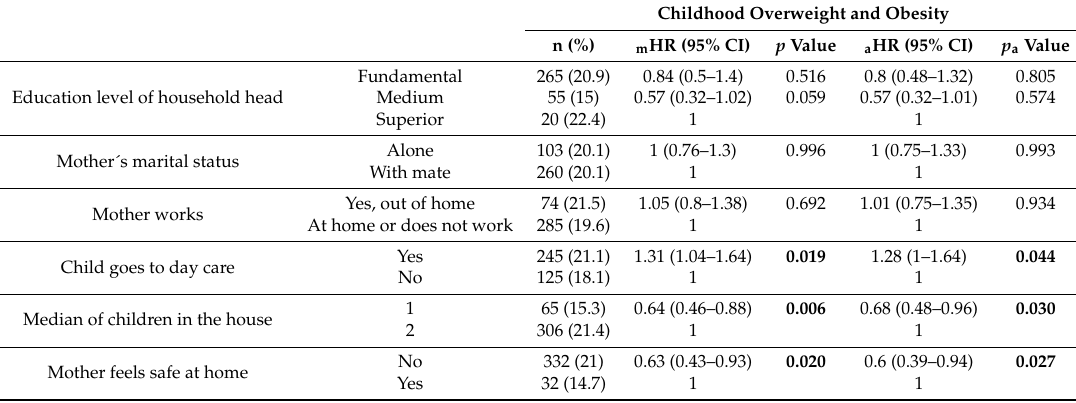
Table 3. Home environment factors associated with overweight / obesity in children aged 2–6 years, Cear á , 2017.